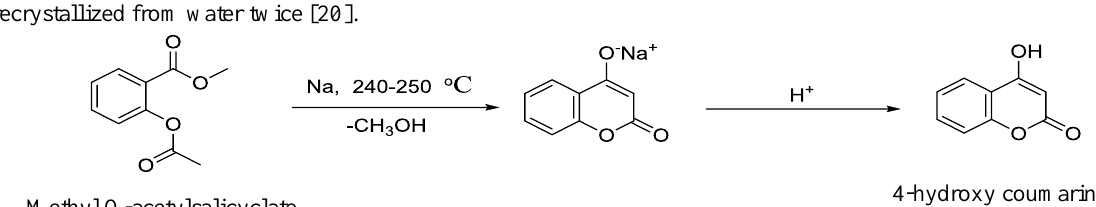
Figure 4. Reaction scheme for the synthesis of 4-hydroxy